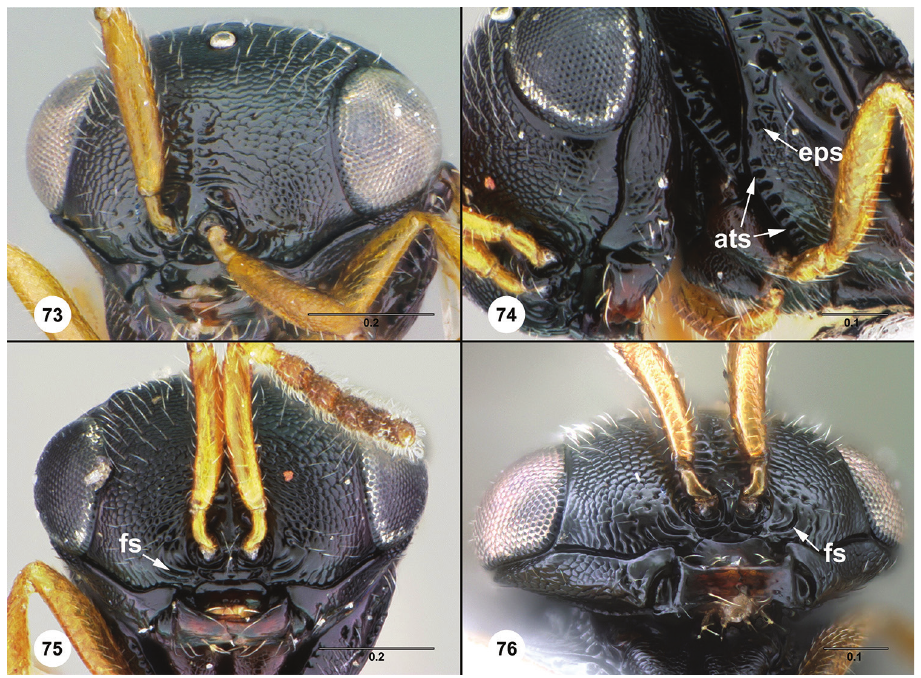
Figures 73–76. Trissolcus gonopsidis 73 female (OSUC 542413) 74 male allotype (USN- MENT00764938), head and mesosoma, ventrolateral view 75 male allotype (USNMENT00764938), head, anterior view 76 female (OSUC 542413), head, ventral view. Scale bars in millimeters. lar crescent: dorsoventrally strigose. Area bounded by axillar crescent: punctures visible in at least ventral half, not quite striate. Macrosculpture of mesoscutellum: absent. Microsculpture on mesoscutellum: present throughout. Setation of posterior scutel- lar sulcus: present. Form of metascutellum: multiple rows of cells. Metanotal trough: foveate, foveae occupying more than half of metanotal height. Metapostnotum: invagi-